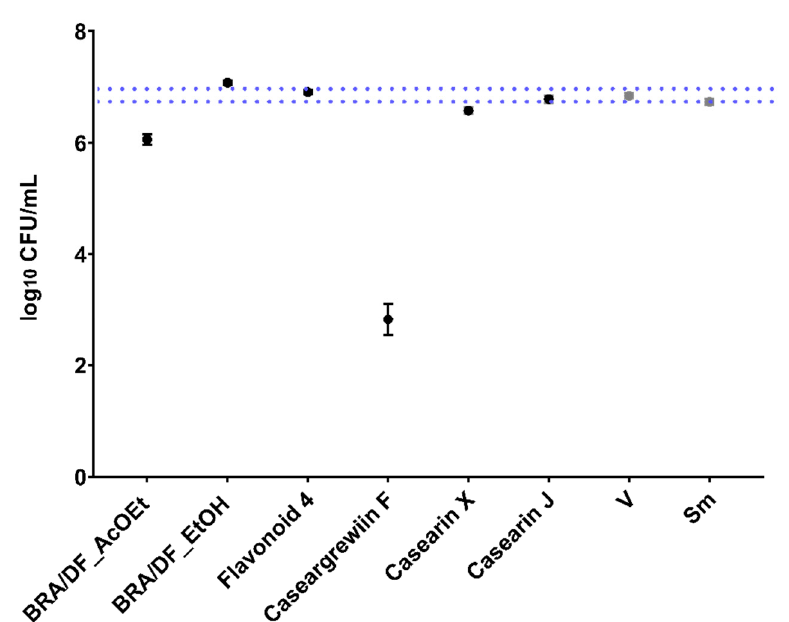
Figure 3. Log 10 CFU of pre-formed biofilms (48 h old biofilms) treated by fractions (500 µ g/mL), flavonoid (125 µ g/mL), and casearins (125 µ g/mL). The central data are the mean, and the error bars are the confidence interval (95% CI). The dotted lines use vehicle data to compare the effectiveness of tested treatments. The growth control (no treatment) is represented as Sm for S. mutans and V for the vehicle control (with the concentration in each well being 1.75% EtOH and 0.31% DMSO). The experiments were performed in triplicate on two separate occasions ( n = 2).